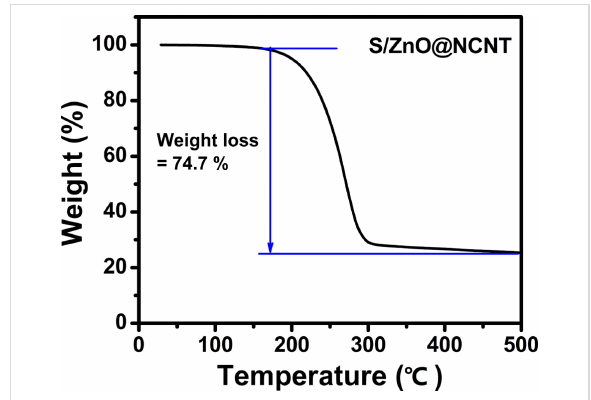
Figure 2: TGA curve of the S/ZnO@NCNT composite.